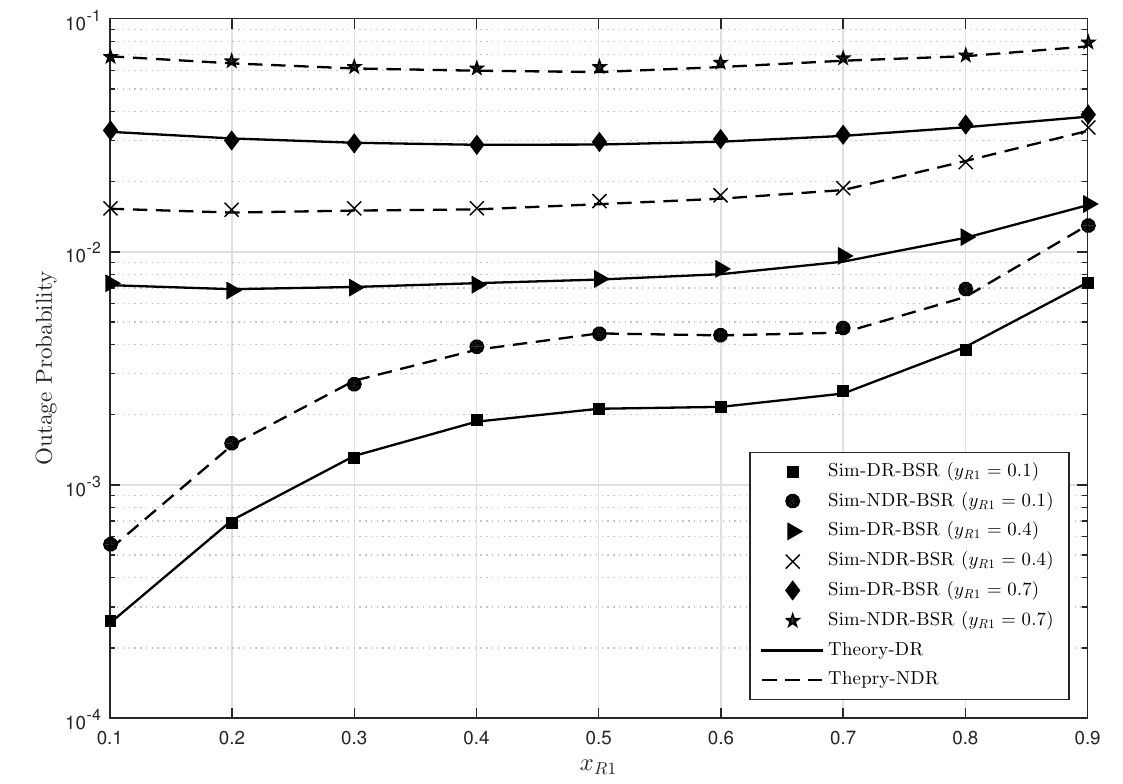
Figure 4. Outage probability versus x of the DR-BSR and NDR-BSR protocols for y R 1 (0 . 5 , − 0 . 3) , P = 5 dB, ψ t = 1 bits/s/Hz, ρ = 0 . 5 , η = 0 . 5 , M = 3 , and N = 3 . increasing N . 3) The DR model outperformed the NDR model, and the BSR scheme outperformed the RAN scheme. 4) The outage performances of all protocols improved when the transmit power P increased, the energy harvesting e ffi ciency η increased, the distances between the two clusters and the source and the destination decreased, or the target rate ψ t decreased. 5) The theoretical results match the simulation results